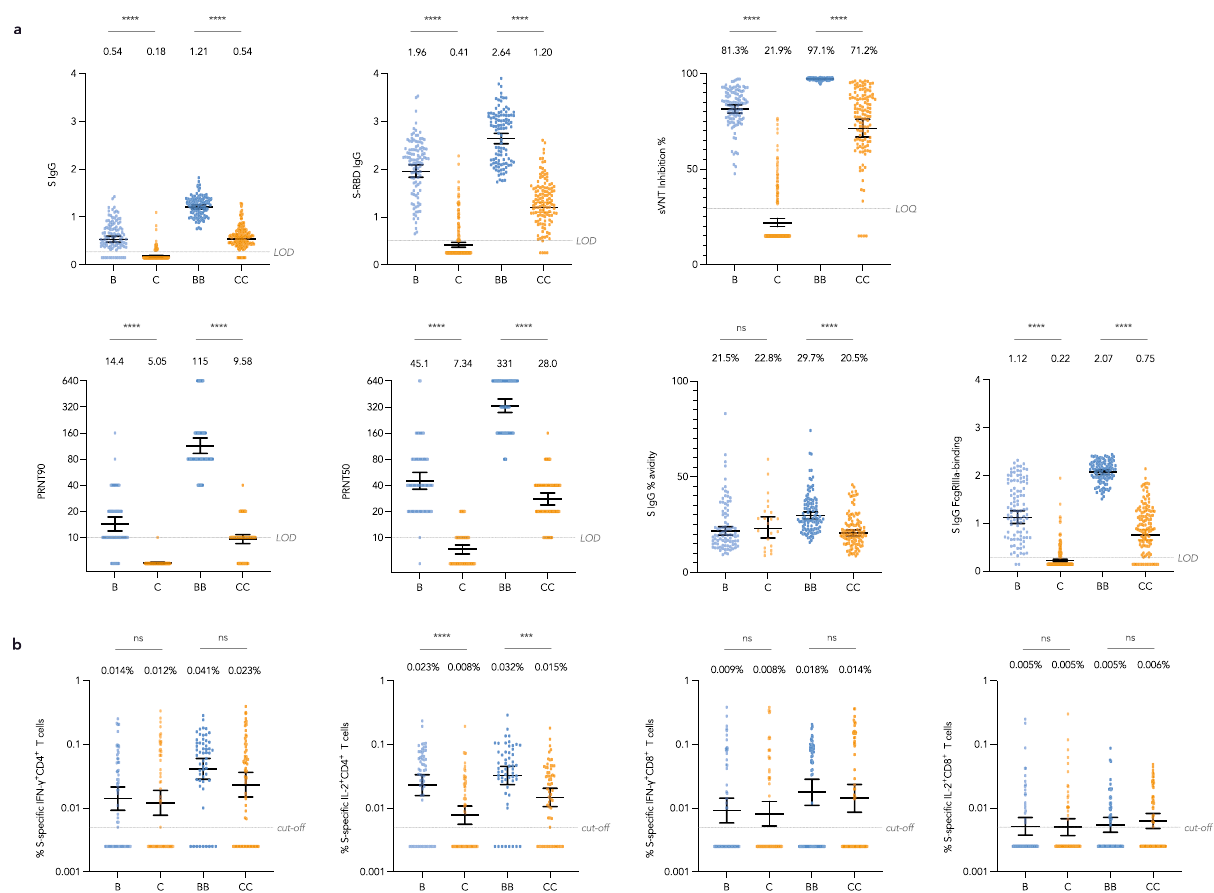
Fig. 3 Antibody levels against S were higher for BNT162b2 than CoronaVac in adolescents. Humoral and cellular immunogenicity was compared between vaccines in adolescents at 21-28 days after 1 dose and 28 days after 2 doses. a There were lower humoral responses after CC than BB as measured by S IgG (adolescent CC N = 116, adolescent BB N = 103) (GM OD450 0.54 vs 1.21; GMR 0.44, 95% CI 0.40 – 0.49), S-RBD IgG (adolescent CC N = 119, adolescent BB N = 104) (GM OD450 1.20 vs 2.64; GMR 0.46, 95% CI 0.41-0.50), sVNT (adolescent CC N = 119, adolescent BB N = 104) (GM %